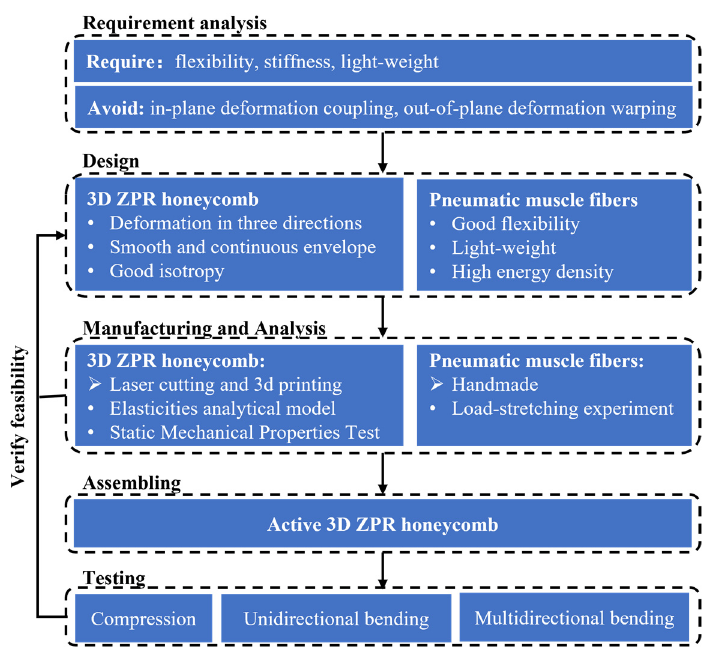
Figure 1. The structure and organization of the paper.